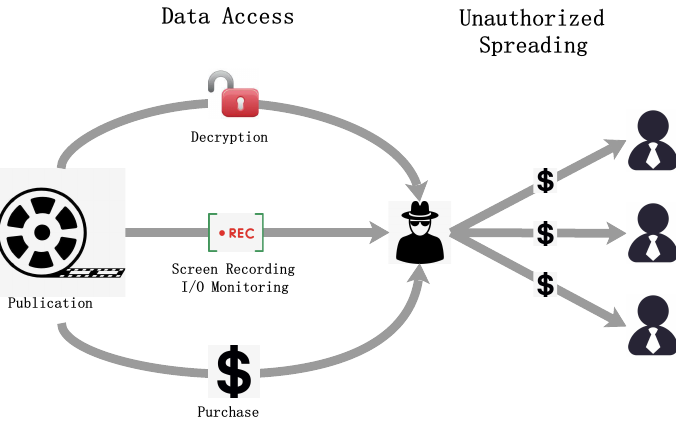
Figure 1. The threat model in digital rights management